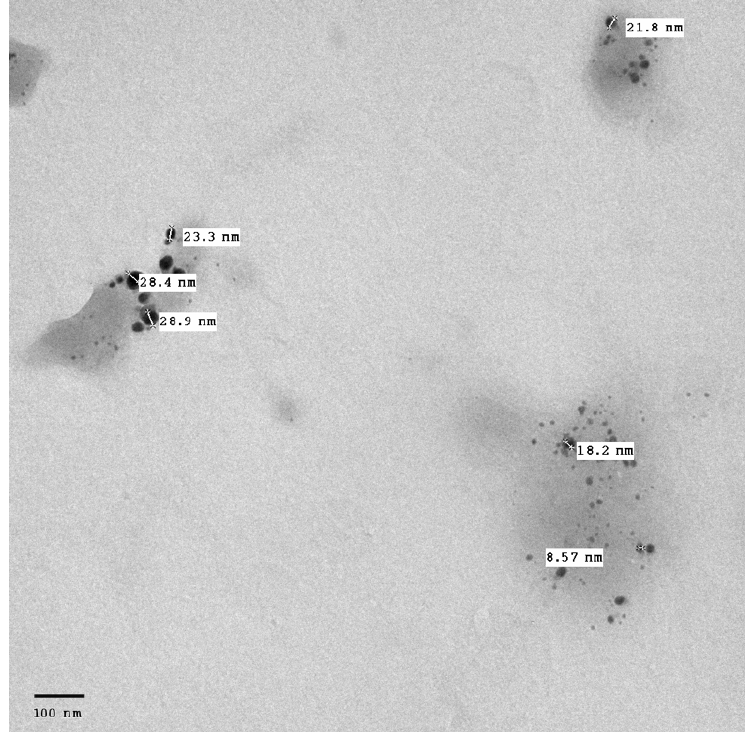
* IC 50 were calculated by non-linear regression curve fir using GraphPad prism. Figure 2. TEM micrograph of Cynara scolymus flower extract AgNPs. Mag. 80,000×. Figure 2. TEM micrograph of Cynara scolymus flower extract AgNPs. Mag. 80,000 × .